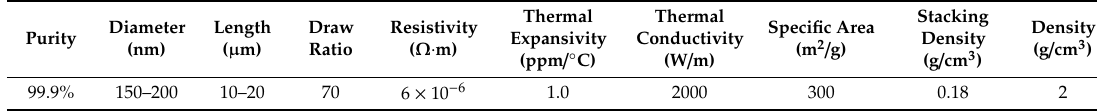
Table 4. Physical parameters of carbon nanofibers.